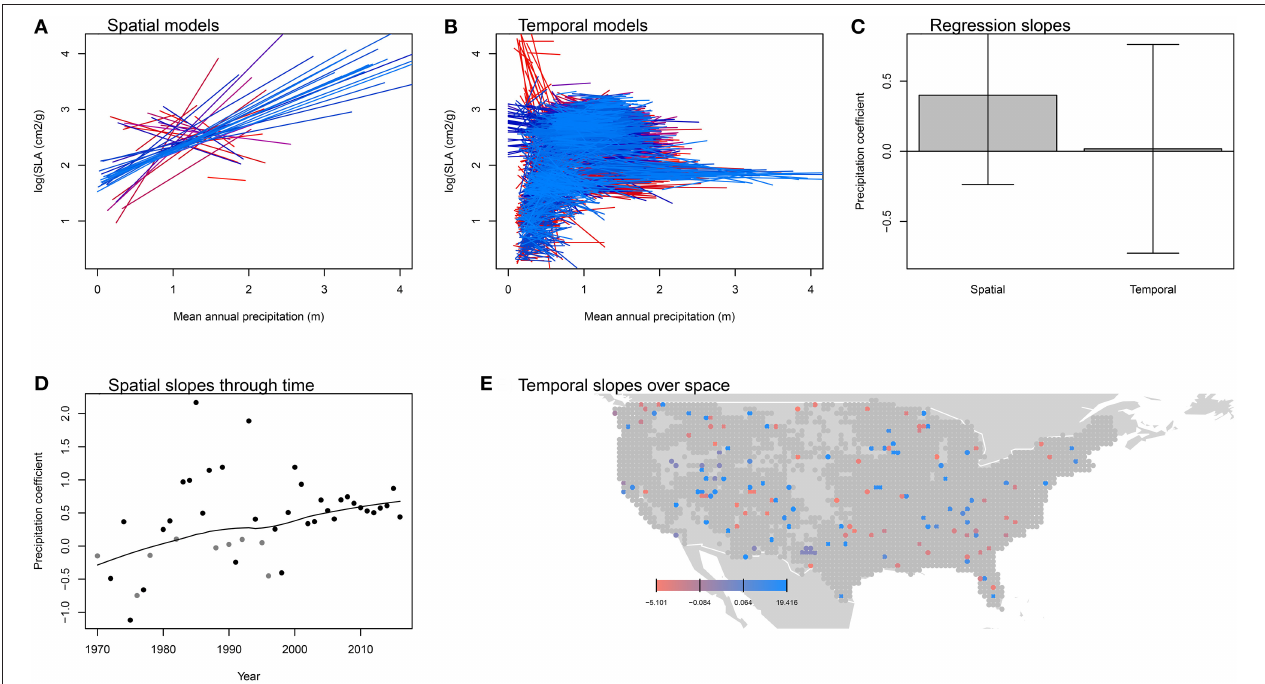
FIGURE 2 | Spatial and temporal relationships between SLA and precipitation. (A) Shows the spatial models for each year between 1970 and 2016 (earlier years are in red, later in blue). (B) Shows the temporal models for each 0.5 x 0.5 degree grid cell. (C) compares the distributions of these coefficients, showing their mean and standard deviation. (D,E) show the pattern of spatial coefficients over time and temporal coefficients over space, respectively. In (D,E) , points are gray if the regression coefficients was not significant in that year or